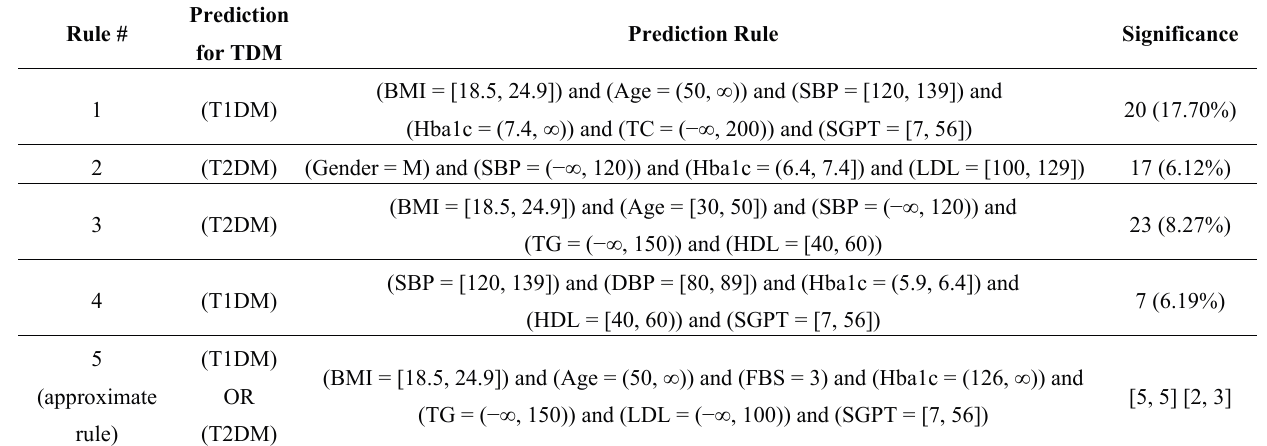
Table 8. A Partial list of rules extracted from discretized information system (DIS) using rough set (RS) learning from example module, version 2 (LEM2)